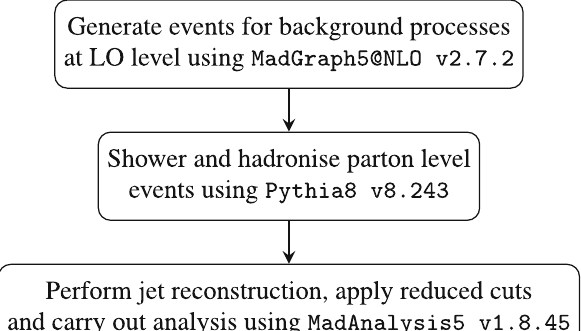
Fig. 14 Description of the procedure used to generate and analyse MC events for background processes